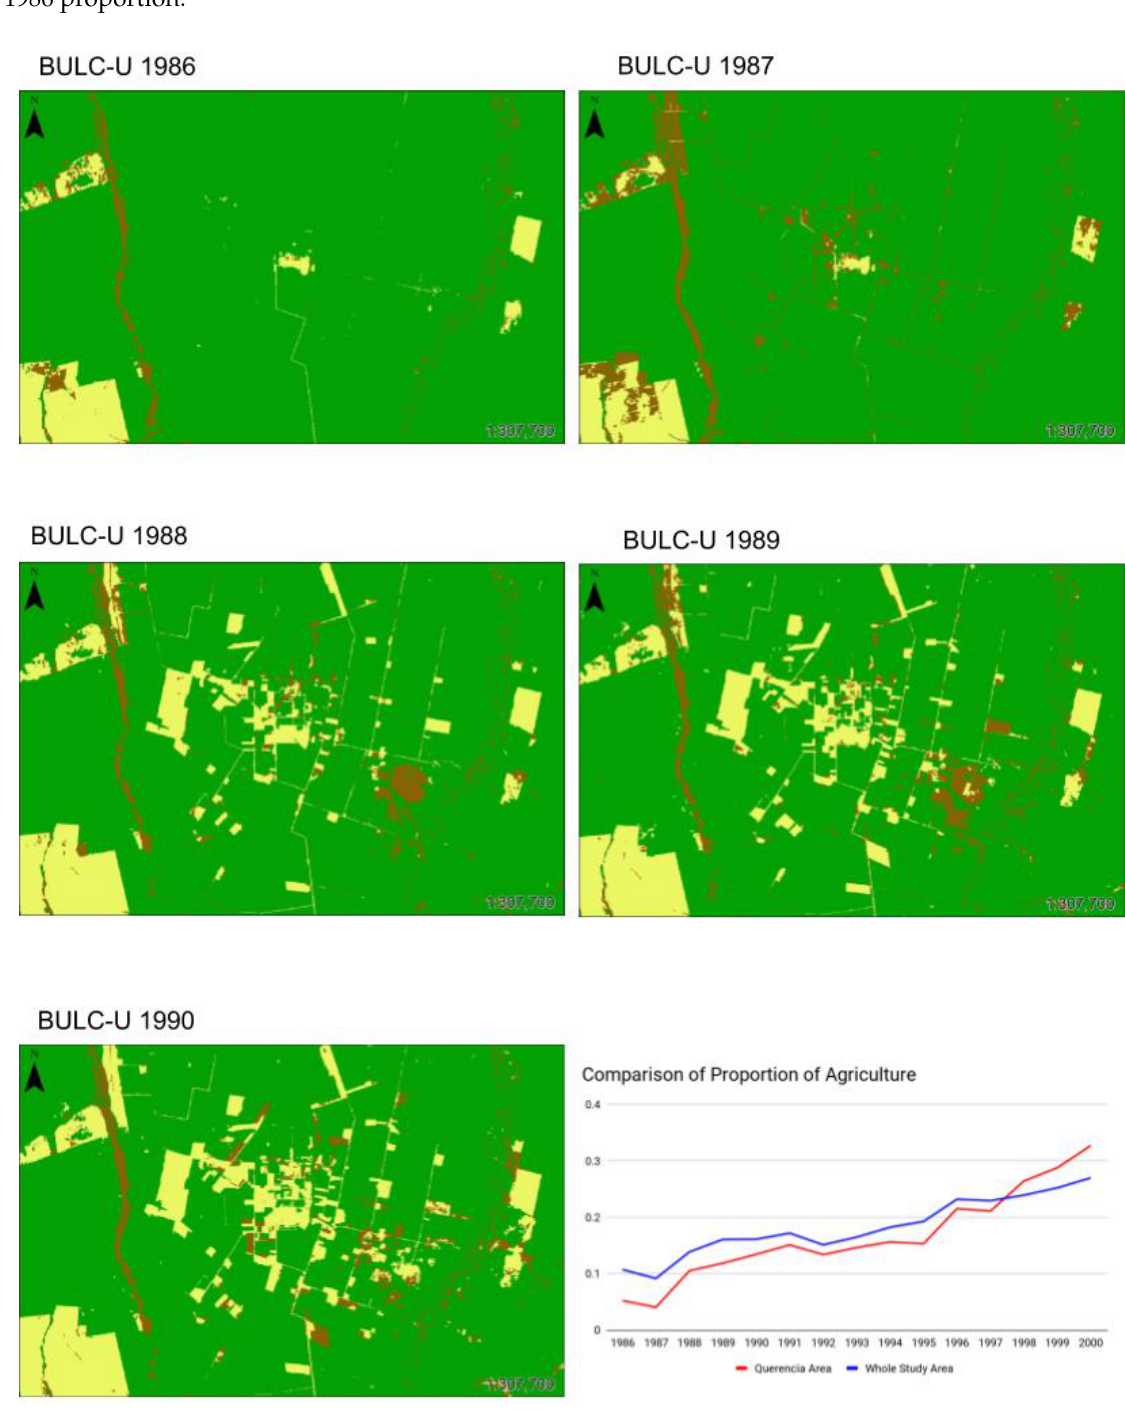
Figure 9. Land cover in Querência during early part of the study period: 1986 – 1990.